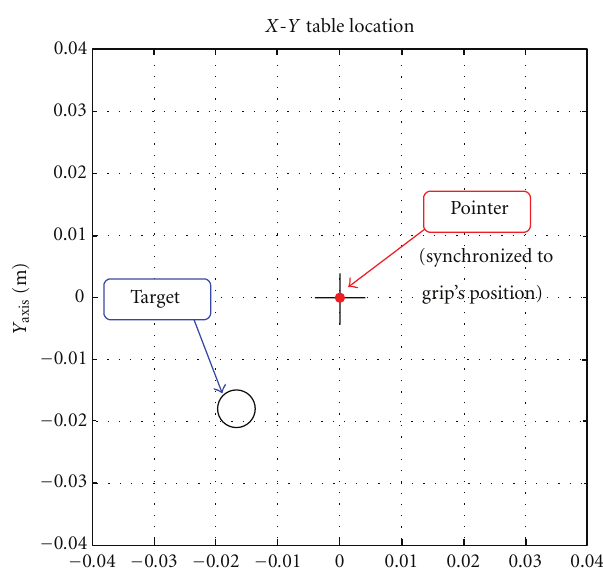
Figure 4: Operation monitor of the haptic interface